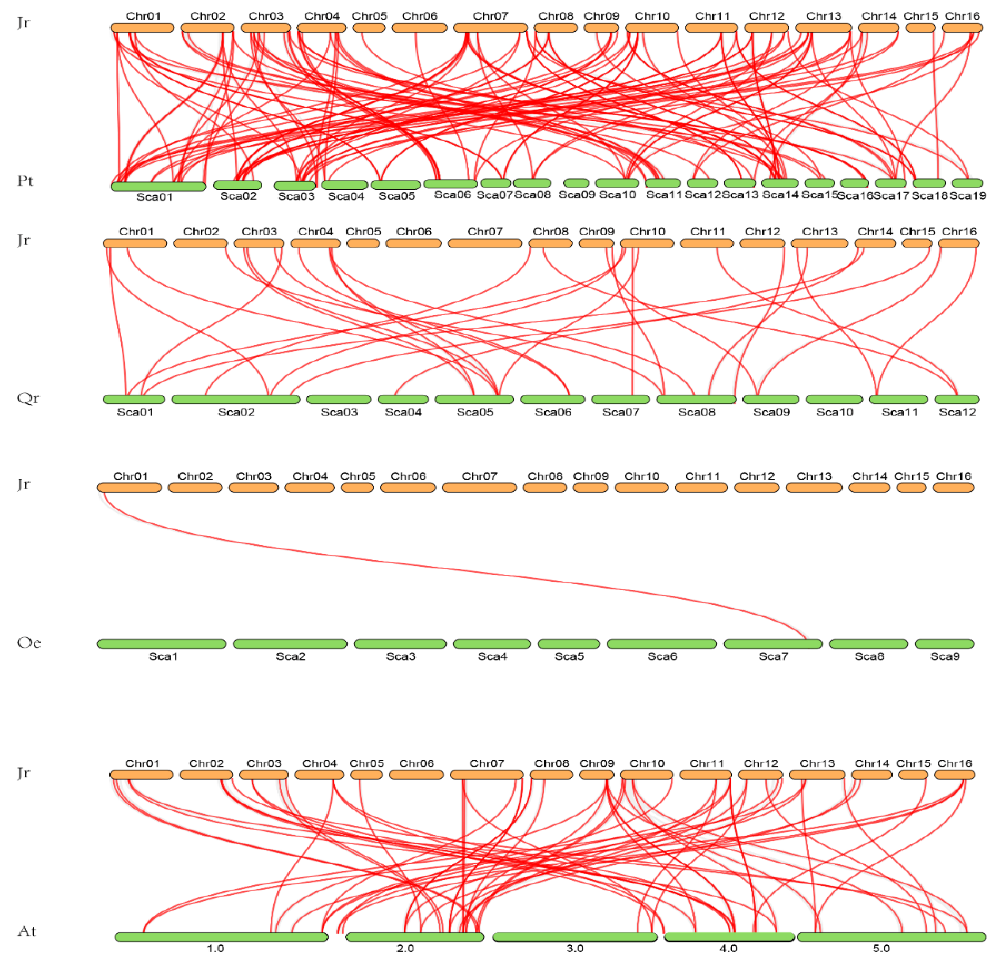
Figure 6. Syntenic analysis of WRKY genes with other species. Pt indicates P. trichocarpa ; At indicates A. thaliana ; Oe indicates Olea europaea ; Qr indicates Quercus robur